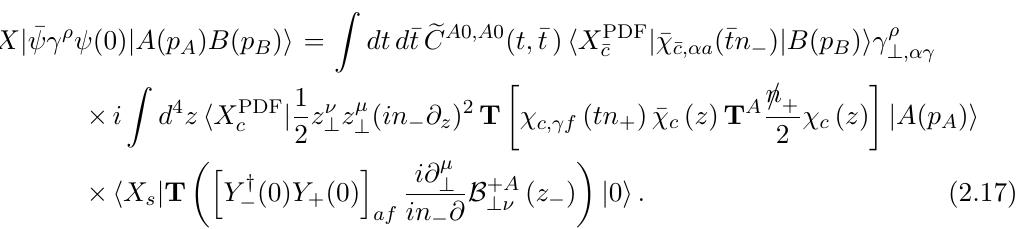
(2) into a collinear quark line. 2 (cid:24) L